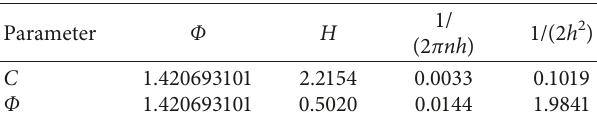
Figure 4: Probability plots of c and φ with different distribution types for (a) normal distribution, (b) lognormal distribution, (c) extreme value distribution, and (d) Weibull distribution. Table 2: Coefficients and PDFs of information diffusion distri- butions for c and φ